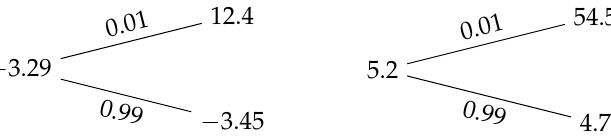
Figure 3. Evolution of the expectation between times t = 0 and 1 (Example 1). Left : evolution for X . Right : evolution for Y